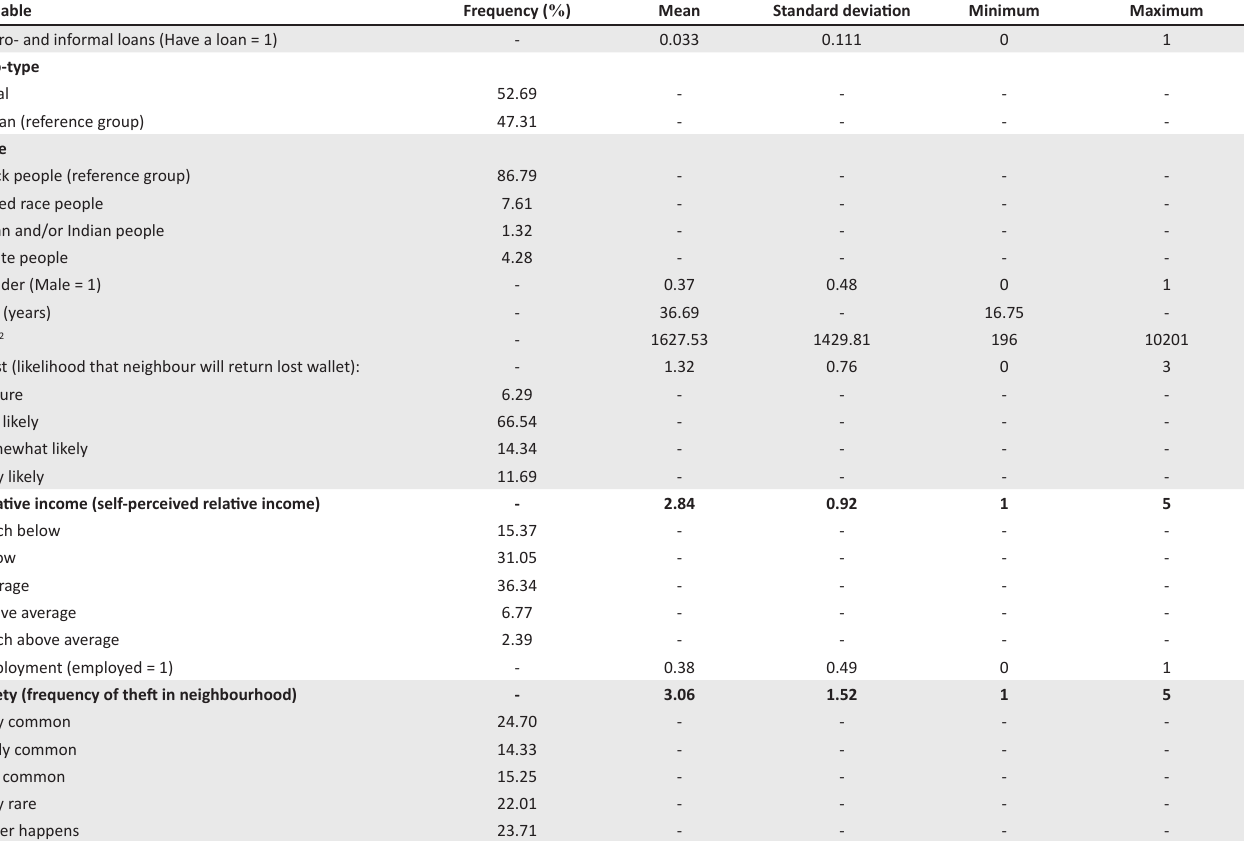
TABLE 3: Descriptive statistics of the variables included in regression analyses.